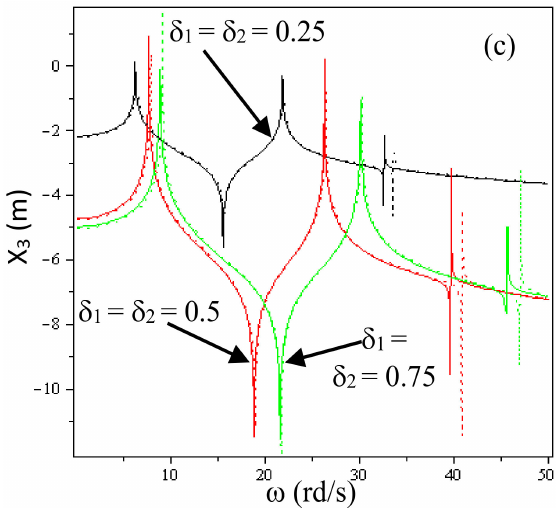
Figure 8. ( a ). Displacement x 1 versus the circular natural frequency ω . Superposition of the solution by the RPM approach (____) and the exact solution (—–). ( b ). Displacement x 2 versus the circular natural frequency ω . Superposition of the solution by the RPM approach (____) and the exact solution (—–), ( c ). Displacement x 3 versus the circular natural frequency ω . Superposition of the solution by the RPM approach (____) and the exact solution (—–).